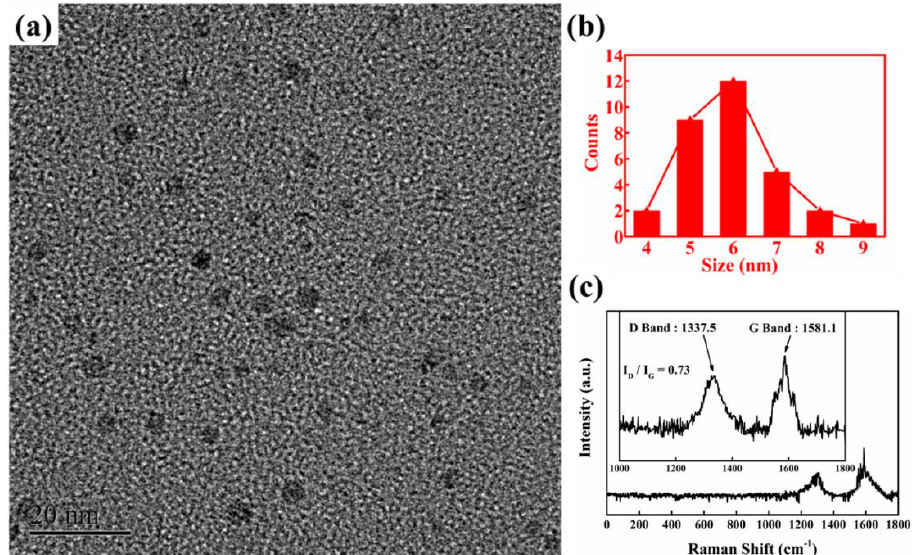
Figure 9. ( a ) TEM image; ( b ) particle size distribution; ( c ) Raman spectrum of N-GQD [97].